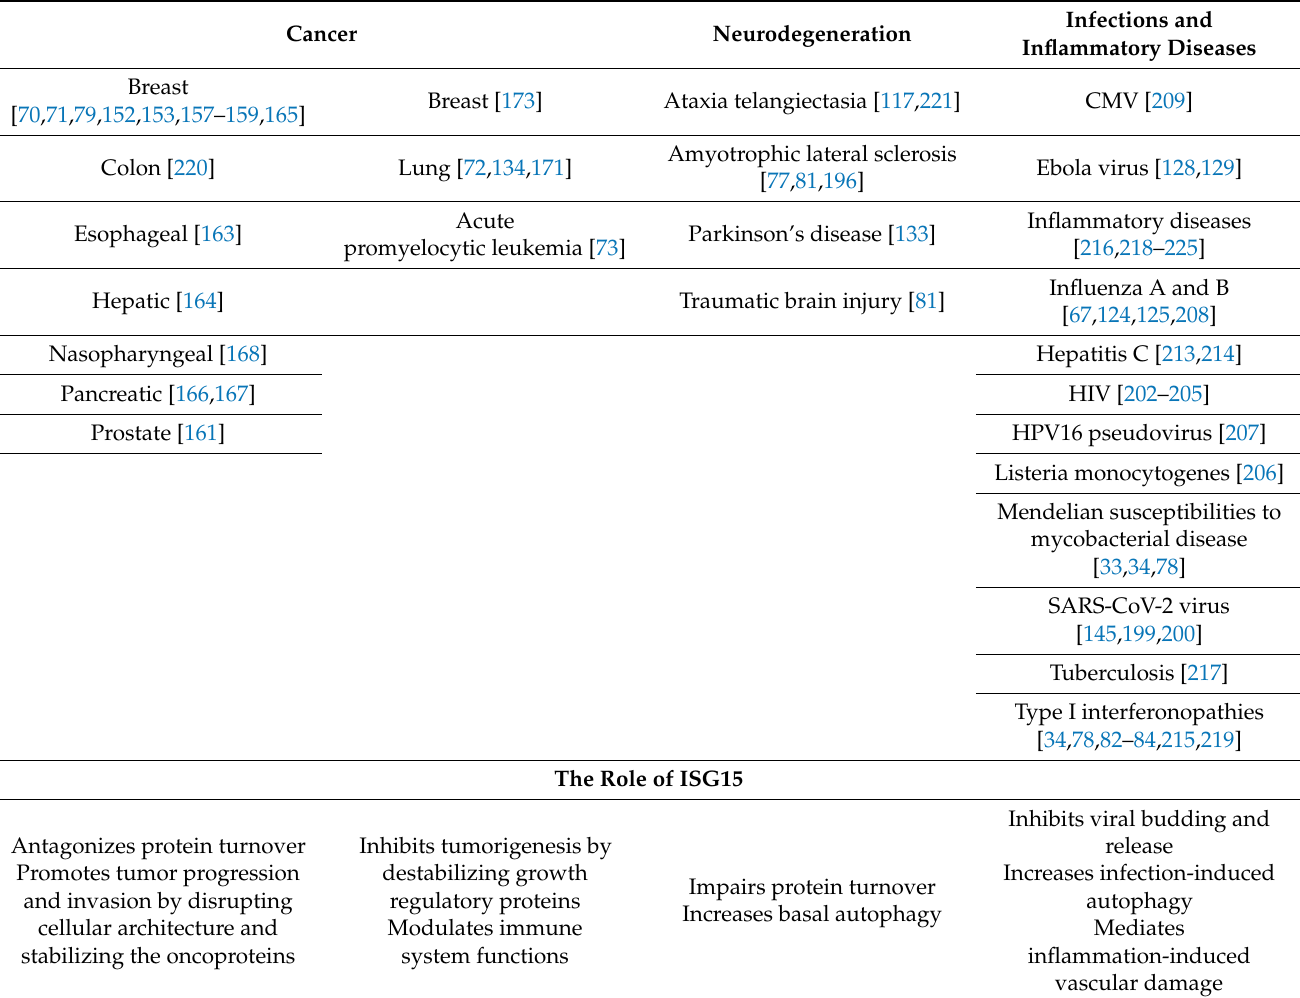
Table 3. The ISG15 Pathway in human